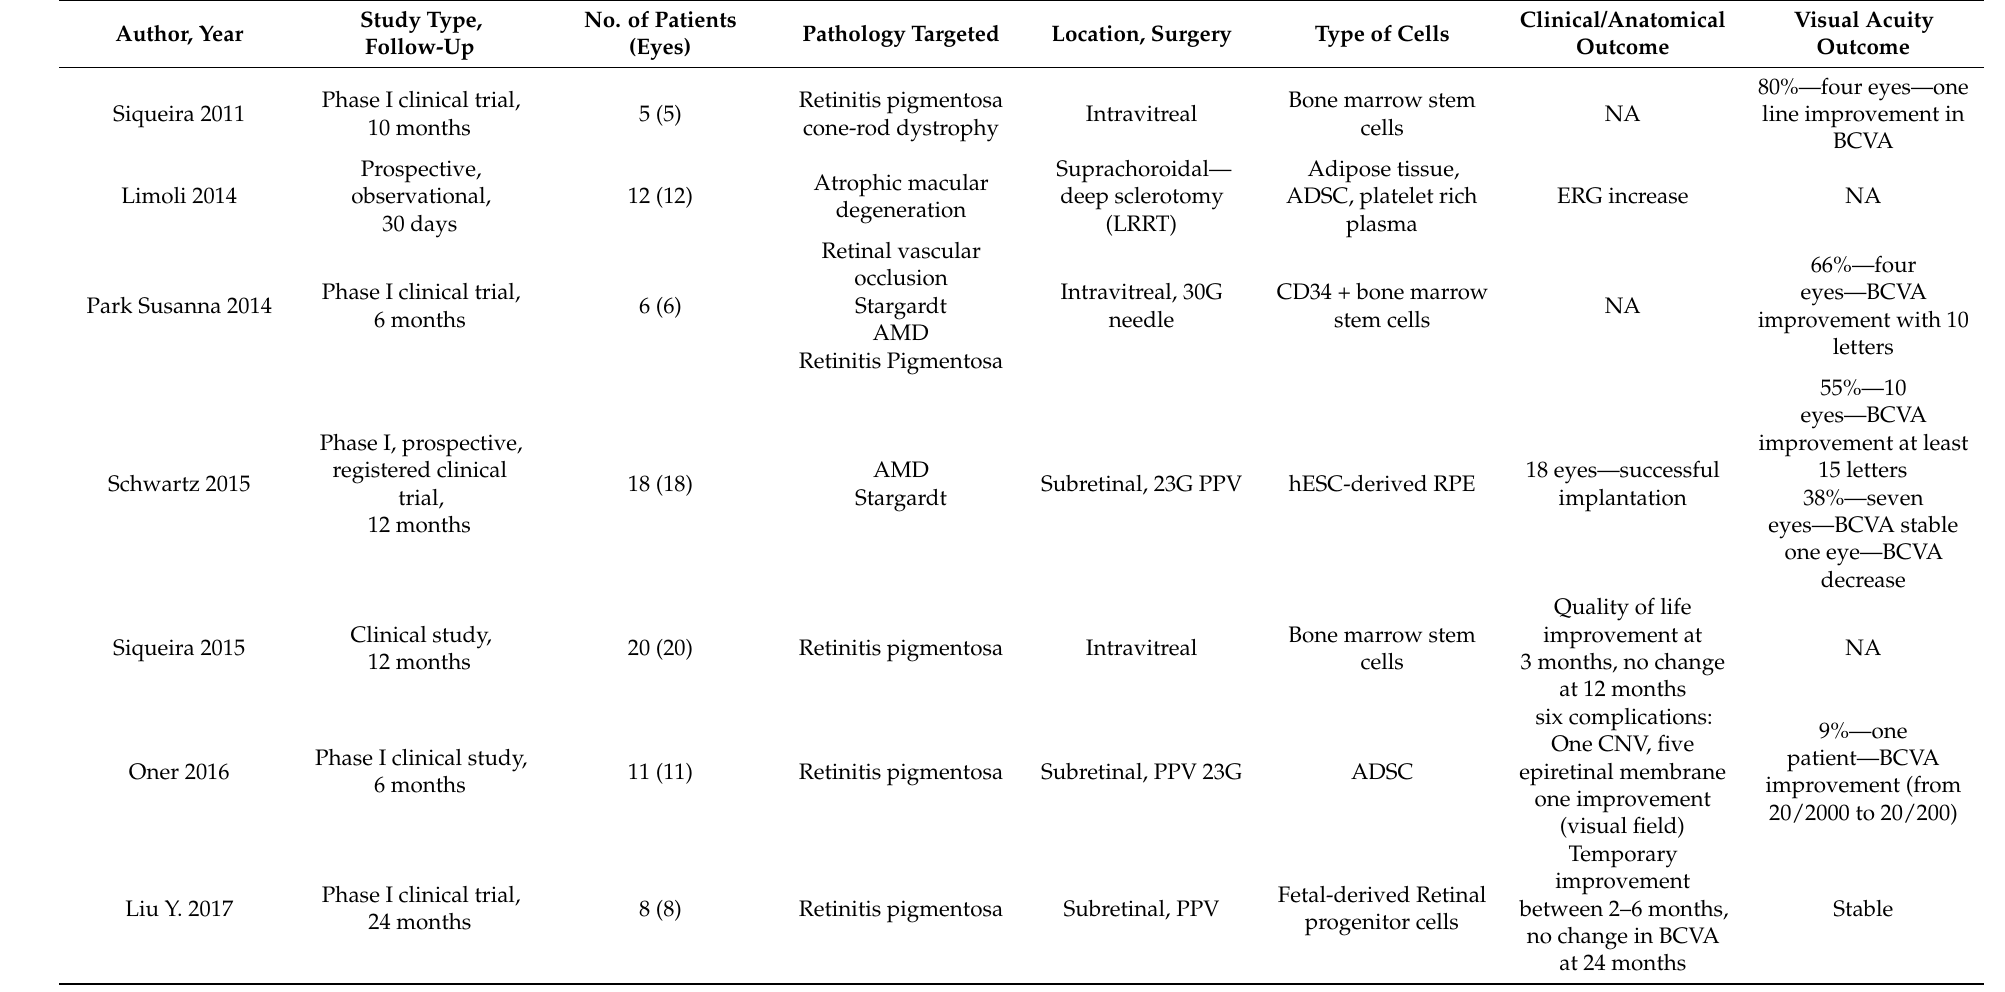
Table 2. Summary of studies involving retinal reconstruction. Study concept and outcome (anatomical and